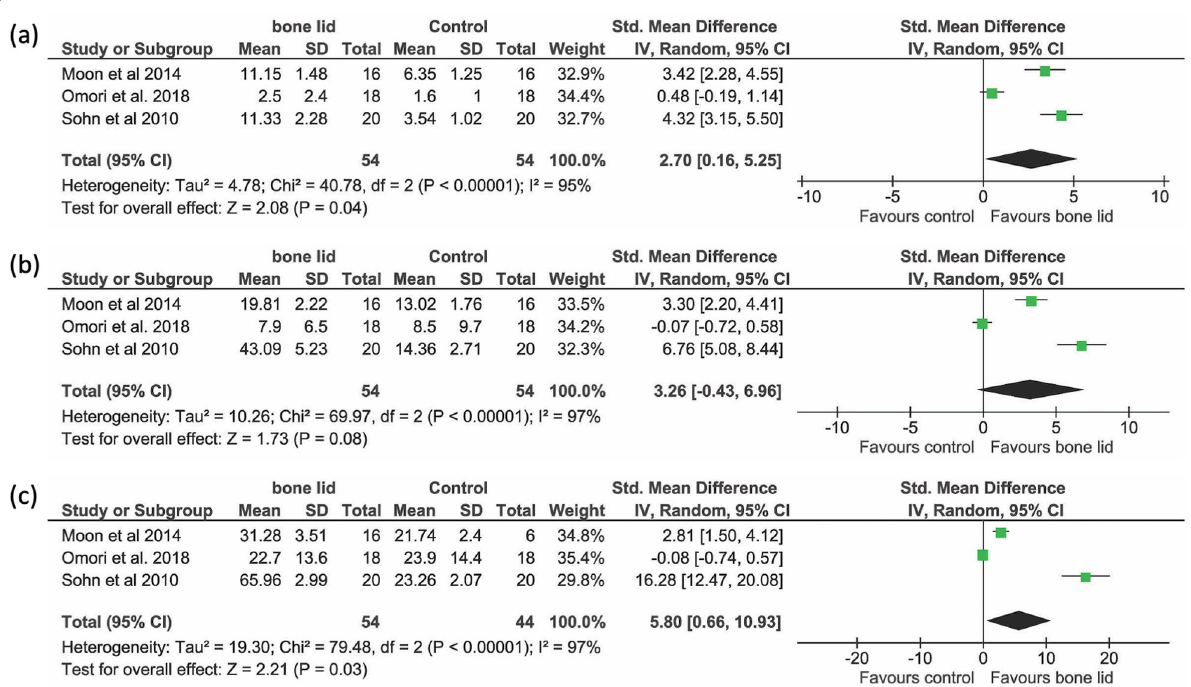
Fig. 4 Forest plots from random ‐ effects meta ‐ analyses of the included animal studies on sinusal new bone formation after ( a ) two, ( b ) four, and ( c ) eight weeks of